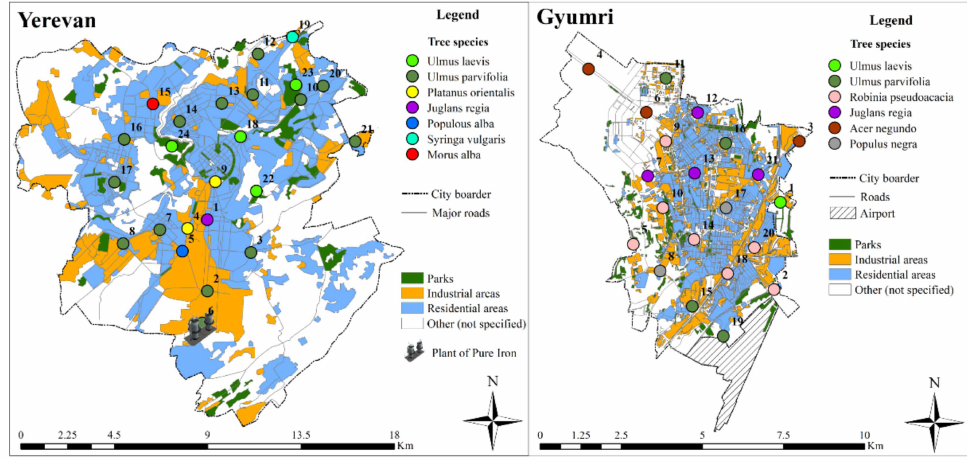
Figure 1. Sampling sites’ distribution in the Yerevan and Gyumri